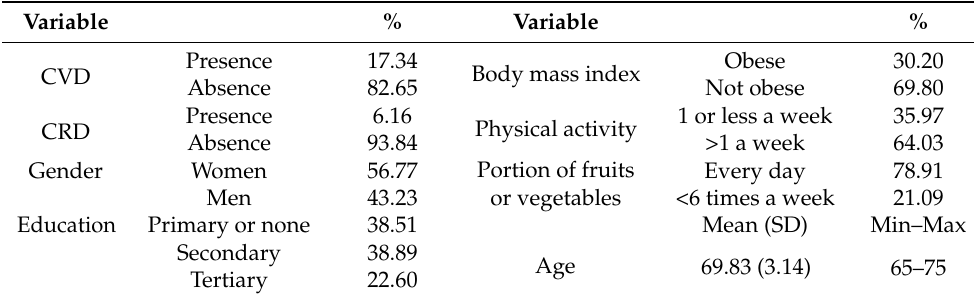
Table 1. Weighted univariate descriptive statistics.